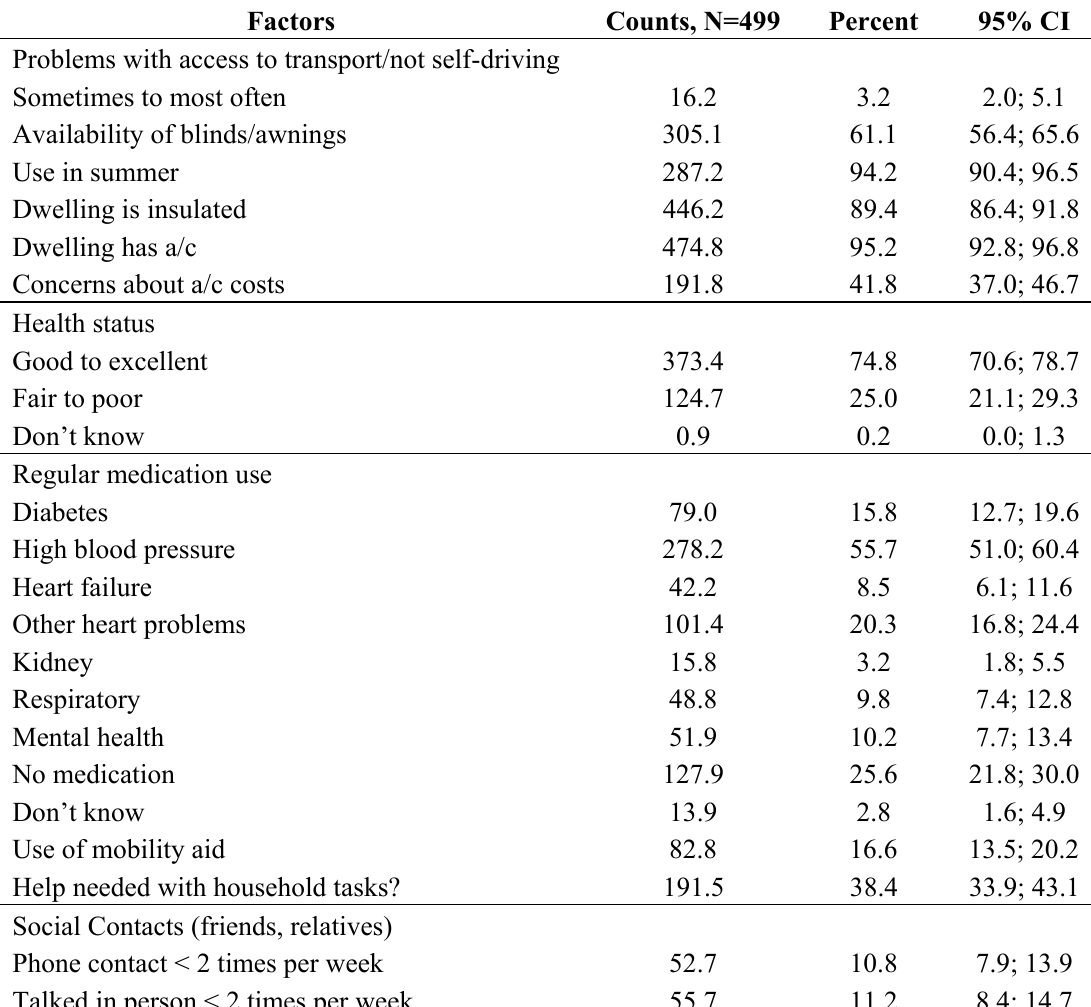
Table 3. Potential heat health risk factors (environment, socio-economic and health status). Weighted counts, percent and 95%